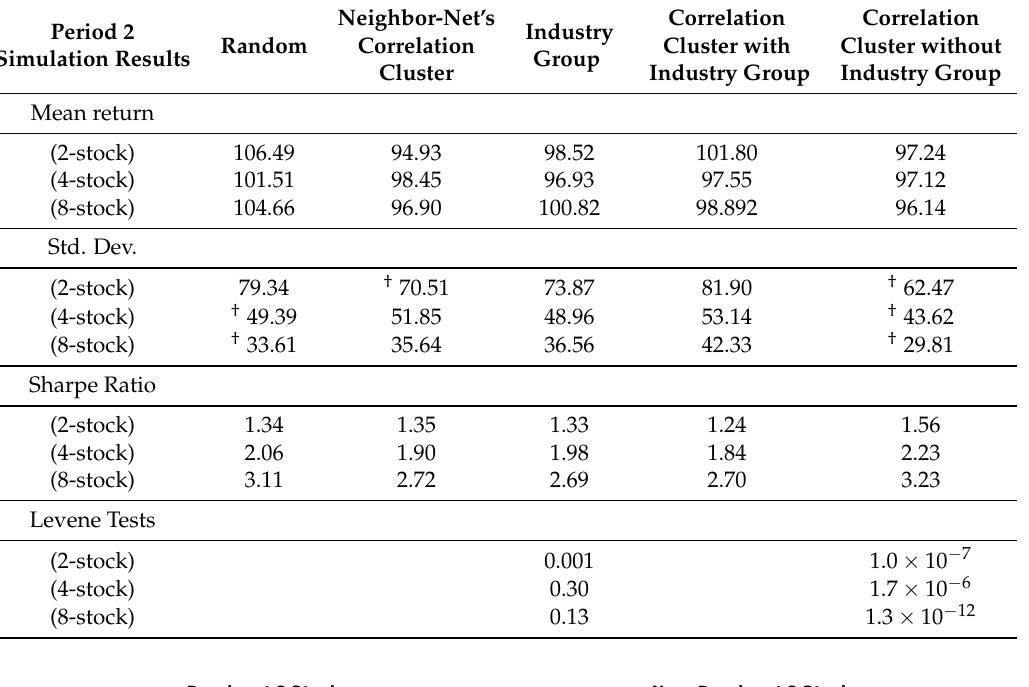
Table 2. Period 2 portfolio performances with standard deviation for three different portfolio sizes. The selection method with the lowest standard deviation is marked with an dagger ( † ).